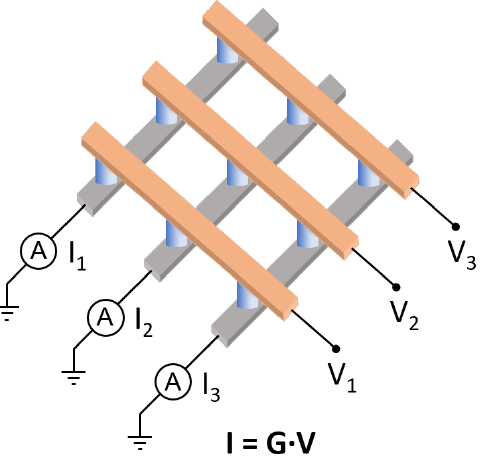
Figure 3. Crosspoint memory structure to perform analog MVM. At the intersection of each TE lines (orange) with each BE line (grey), a RRAM is placed (blue). By programming the RRAM conductance to the matrix entries of A and applying a voltage vector V on the columns, the resulting current flowing in each row j tied to ground according to Kirchoff’s law is I j = ∑ N